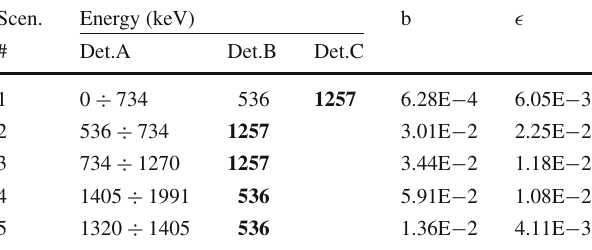
Table 3 The five most relevant scenarios that contribute to the total sensitivity to the two neutrino decay channel by more than 1%. b is the background index (units: counts/keV/kg/y) and (cid:5) the total detection efficiency. The electrons are assumed to be always fully absorbed in the detector ’A’. The final fit is performed at the highest energy monochro- maticpeakmeasuredineachsignature,markedhereinbold.Theenergy ranges in detector ’A’ do not always cover the full 734 keV-wide range to properly evaluate the efficiency (see Sect. 3.2). The observed spectra for each scenario are shown in Fig. 2. Scenario numbers are